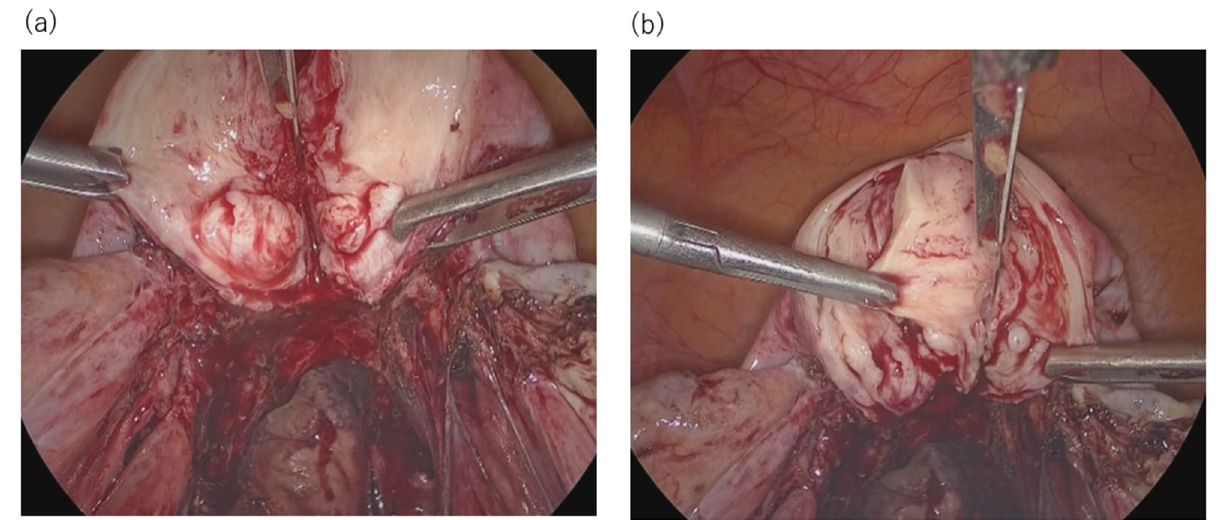
Figure 3. The laparoscopic adenomyomectomy procedure. ( a ) The uterus is longitudinally incised with the scalpel to access the adenomyotic tissue. ( b ) The nucleation is resected in a wide wedge shape with the scalpel in the posterior uterine wall.